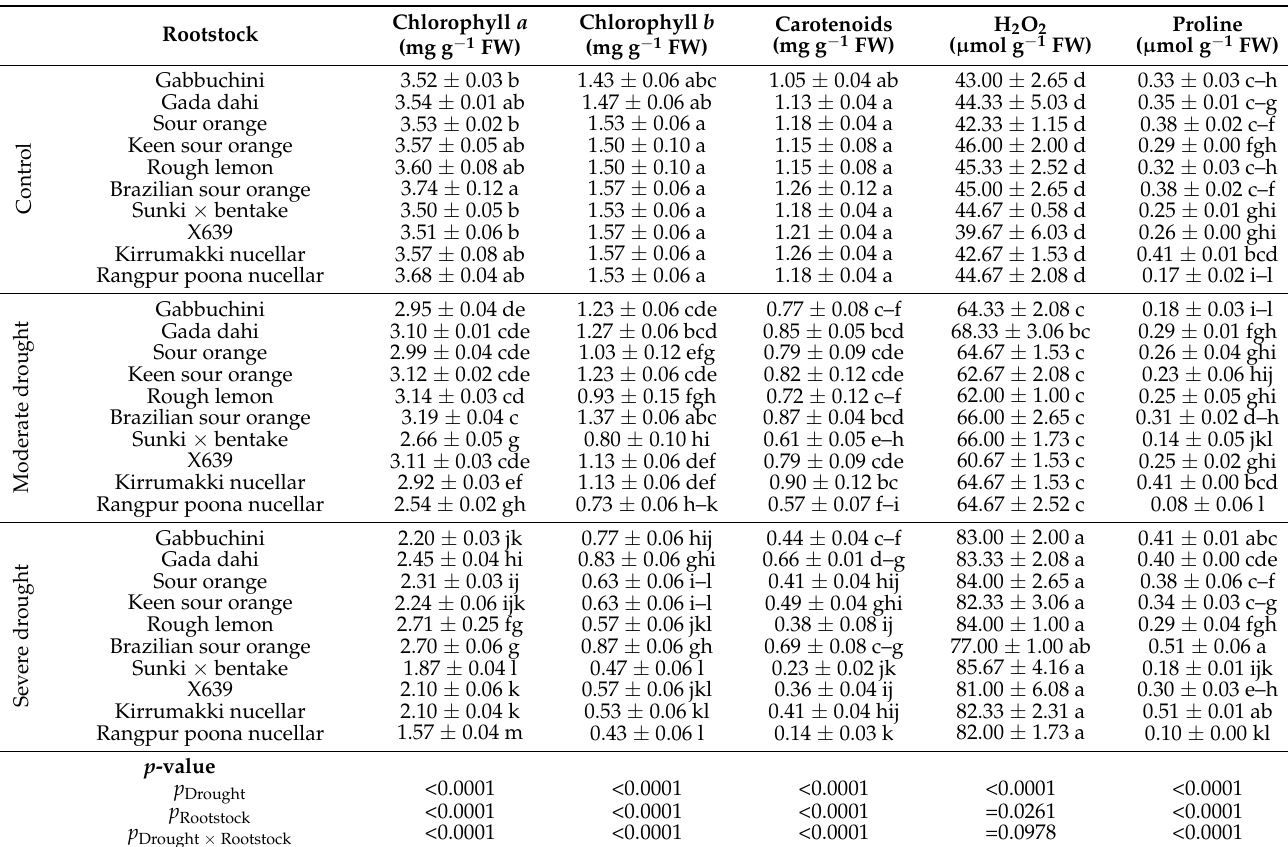
Table 3. Effect of different water regimes on the photosynthetic pigments, H 2 O 2 , and proline content of 10 different citrus rootstocks with distinct degrees of tolerance to drought